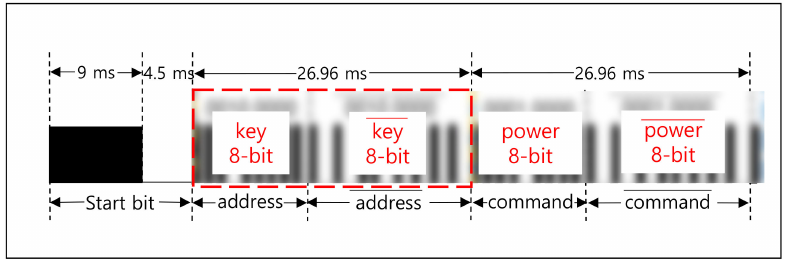
Figure 15. Key transmission via address field in NEC protocol.